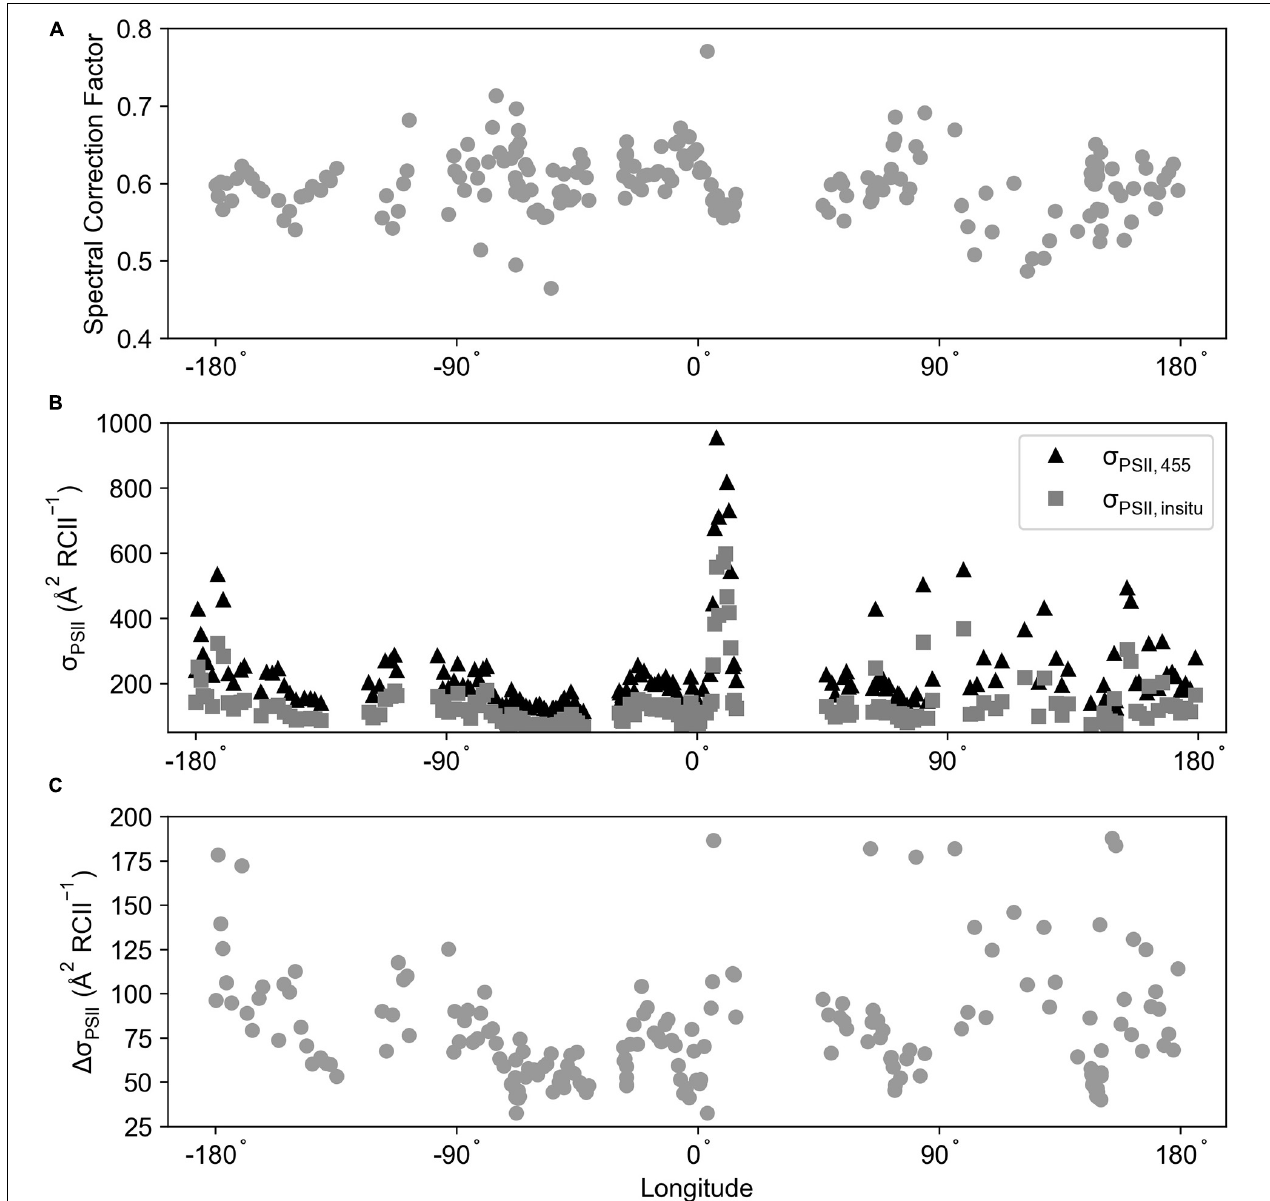
◦ A 2 RCII − 1 ) ◦ A 2 RCII − 1 ). The σ PSII values were